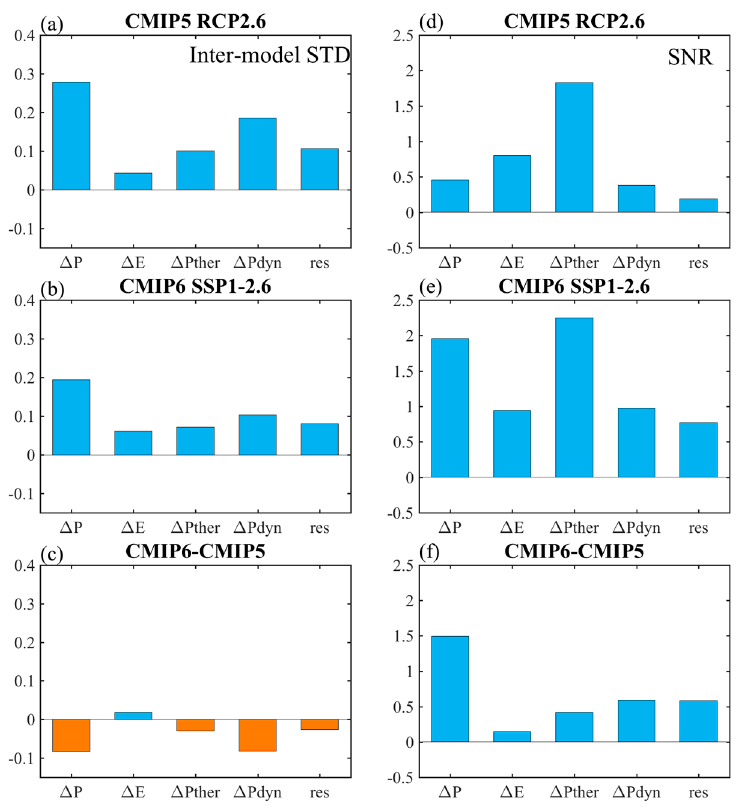
Figure 8. Histograms of ( a–c ) intermodel standard deviation (STD, mm day − 1 ) and ( d–f ) Signal-to-Noise ratio (SNR) for area-weighted-mean (65–90° E and 10–30° N) MME ISM precipitation (mm day − 1 ) and its subcomponents under RCP2.6 and SSP1-2.6 and their differences.